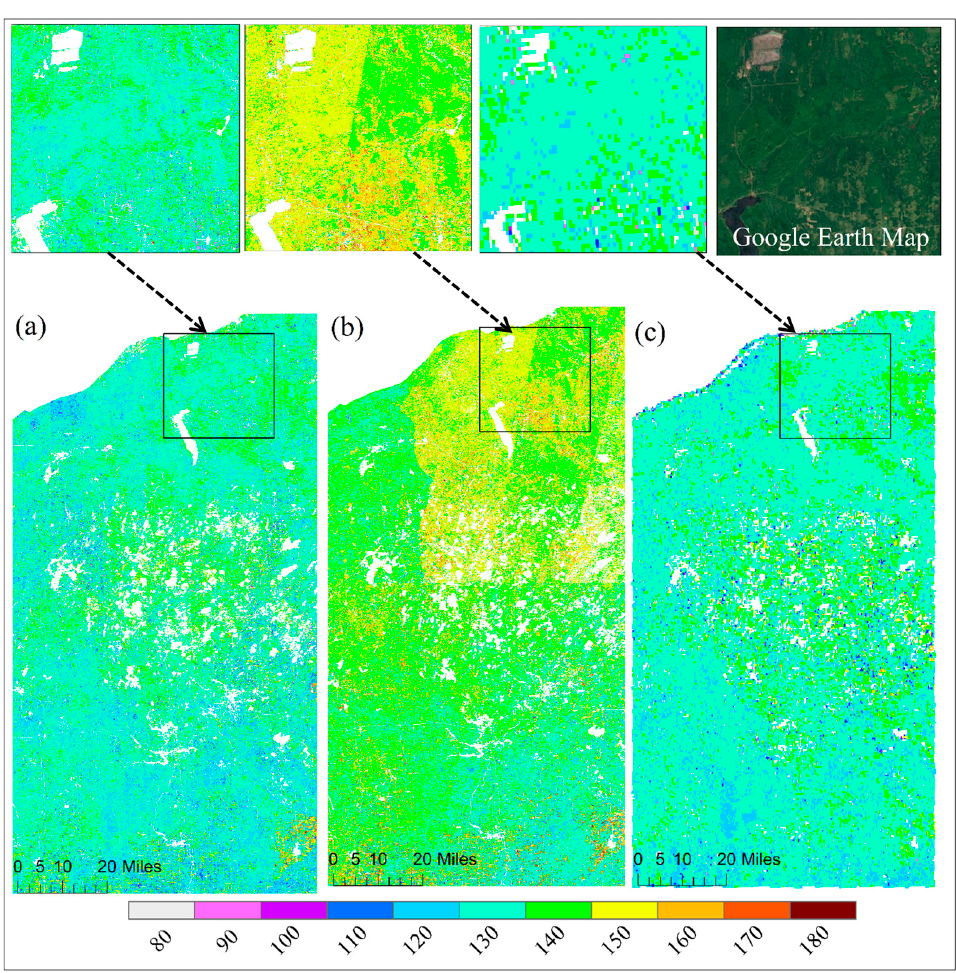
Figure 5. Spatial pattern of greenup onset from ( a ) HLS-ABI, ( b ) HLS, and ( c ) ABI data in the study area. Top panels show an enlarged small area from these detections and from the Google Earth